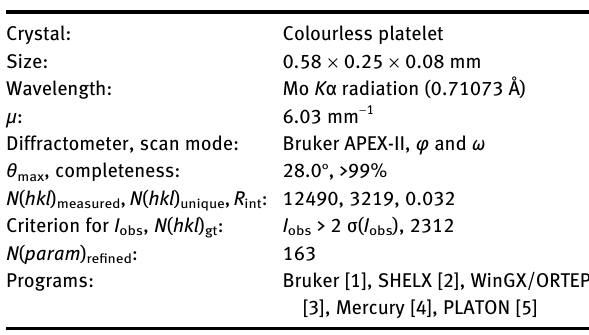
Table  : Data collection and